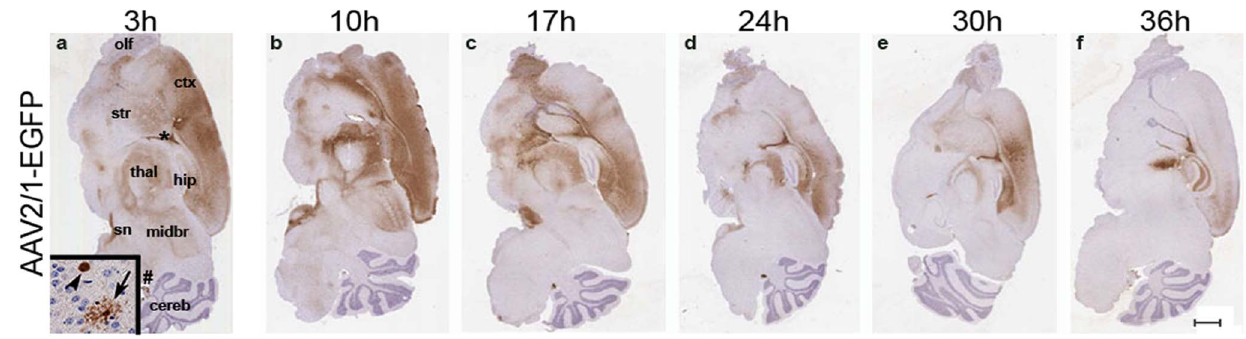
Figure 1. Intracerebroventricular injection of AAV2/1-EGFP at different neonatal ages results in distinctive transduction pattern. Newborn mice were injected with AAV2/1-EGFP into cerebral ventricles at intervals of 6–7 hours till 36 hours postnatal. Representative brain sections from mice aged P21 were stained with anti-EGFP antibody. A representative image of an EGFP expressing neuron (arrowhead) and an astrocyte (arrow) from the cortex is shown (inset, a). Areas of interest, referenced in the manuscript, that show appreciable EGFP expression have been marked as; ctx, cortex; cereb, cerebellum; hpc, hippocampal formation; midbr, midbrain; sn, substantia nigra; str, striatum; olf, olfactory bulb; thal, thalamus; *, lateral ventricle; # , 4 th ventricle. (n=4/group). Scale bar, 500 m m.